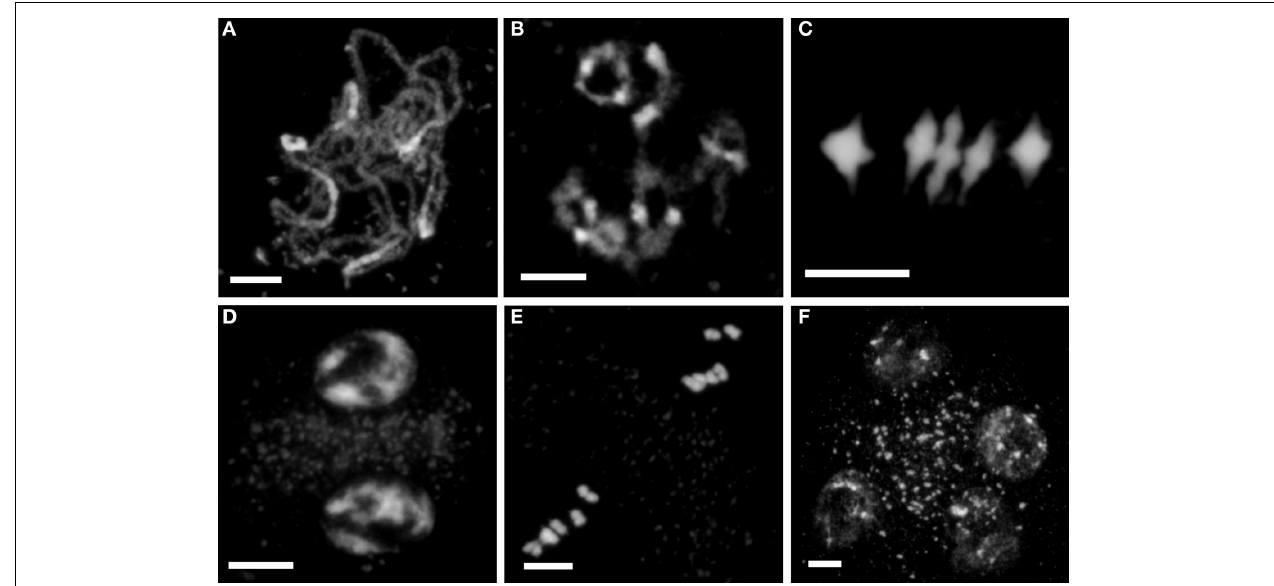
FIGURE 1 | Meiosis is apparently normal in PMCs of ago2-1 , ago5-4 and ago9-1 . No significant meiotic abnormalities were observed in PMCs of the mutants ago2-1 , ago5-4 and ago9-1 , excluding the interlocks displayed by ago9-1 (see text and Figure 2 for more details). Meiotic progression in ago5-4 is shown as example. (A) Fully synapsed pachytene. (B) Diakinesis.